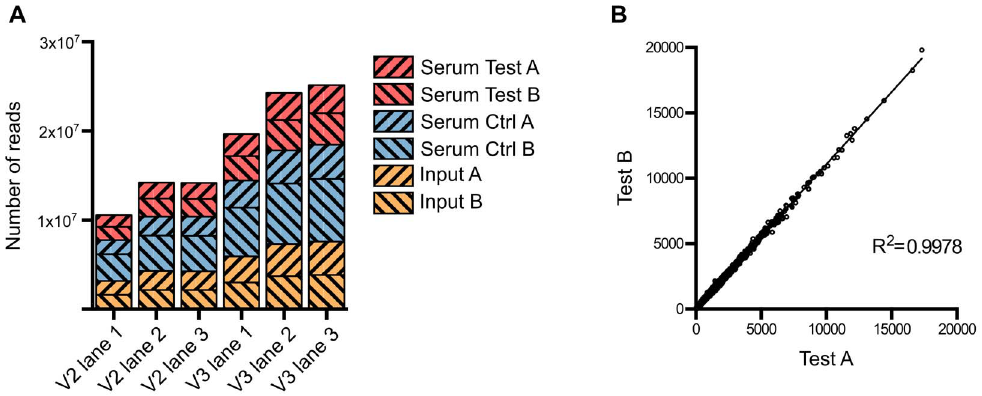
Figure 1. Summary of sequence read data from multiplexed TraDIS. (A) Number of tagged reads obtained in each lane of TruSeq version 2 and version 3 flowcells. (B) Correlation between the two biological replicates. The number of insertions in each gene from Test A was plotted against that from Test B; the correlation coefficient R 2 indicates very low variation between the two replicates.